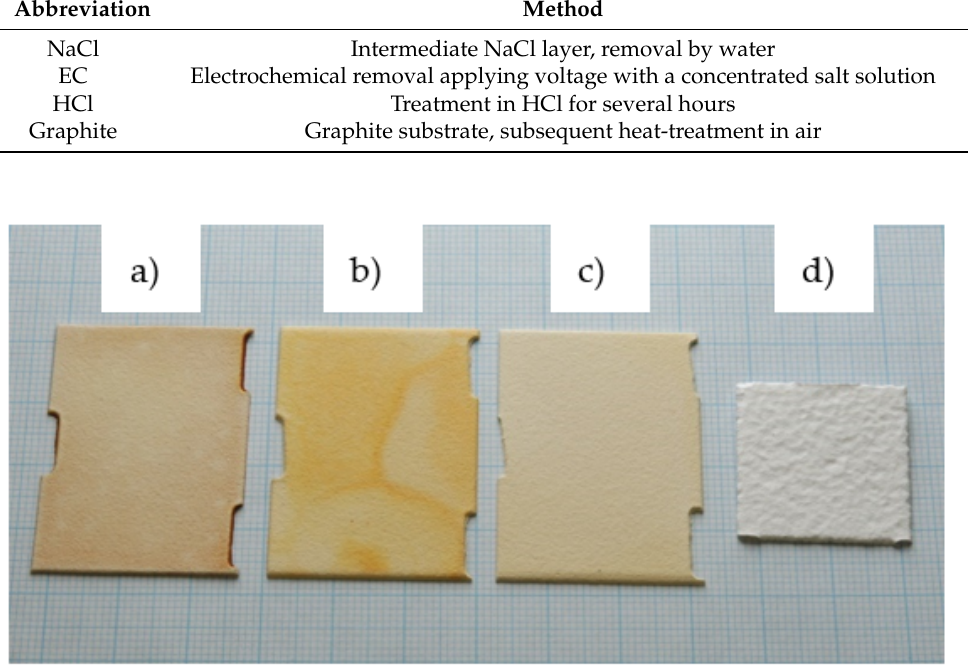
Figure 1. Photo of the YSZ free-standing coatings, from left to right the methods NaCl ( a ), EC ( b ), HCl ( c ), and graphite ( d ) were applied.